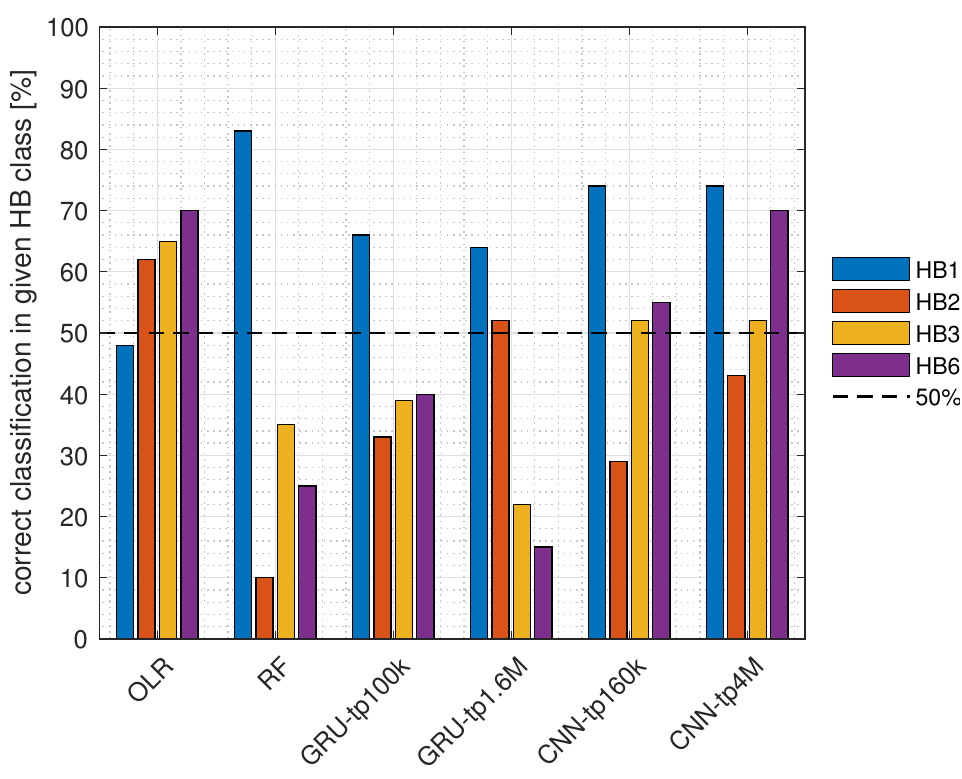
Figure 5. Accuracy of correct classification in different HB classes.